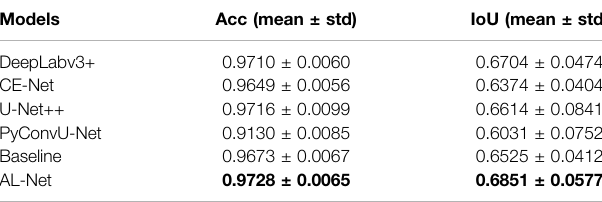
TABLE 6 | The accuracy evaluation of six models on the retinal vessels dataset. Models